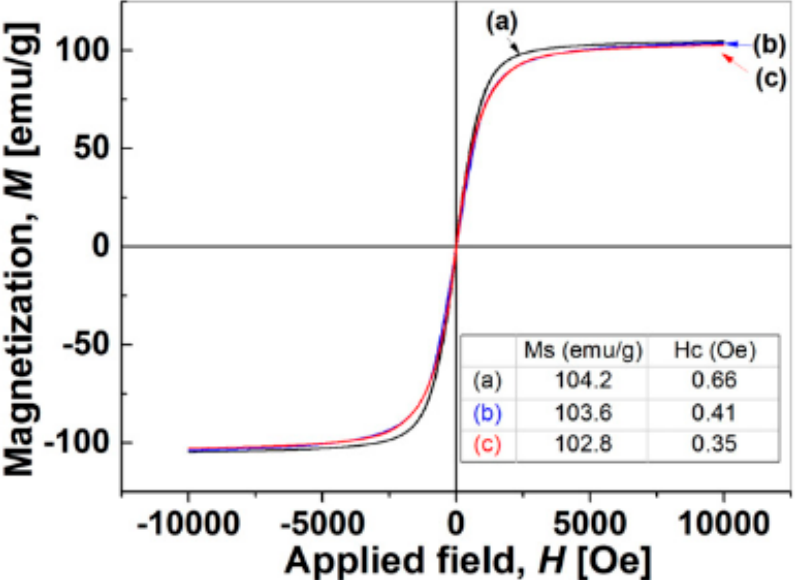
Figure 6. Hysteresis M-H loops of ( a ) parent atomised powder and SLM-processed Fe 68.3 C 6.9 Si 2.5 B 6.7 P 8.7 Cr 2.3 Mo 2.5 Al 2.1 specimens generated with ( b ) v = 2500 mm/s and P = 340 W and (c) v = 1500 mm/s and P = 340 W, reprinted with the permission from [8], Elsevier, 2015 (CGS to SI conversion 1 emu/g = 1 Am 2 /kg and 1 Oe = 79.6 A/m).